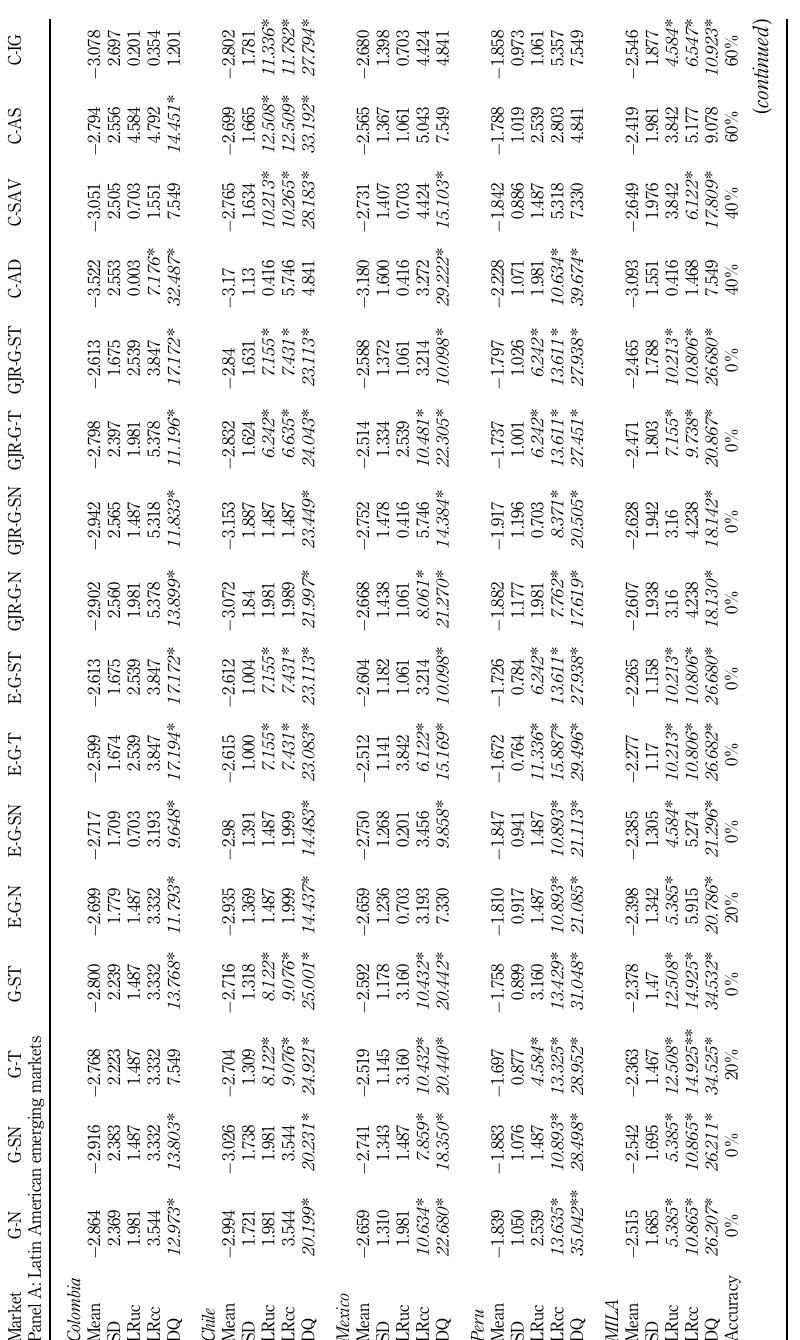
Table 6. Backtesting results